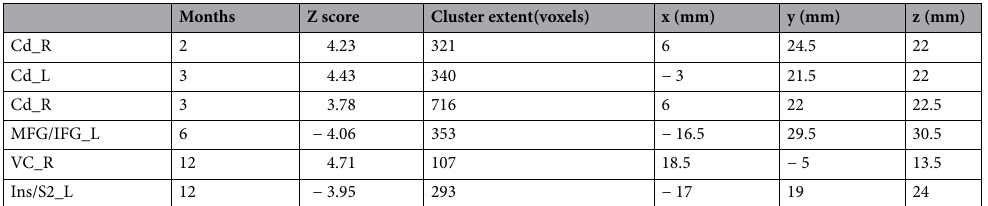
Table 1. GMV differences between the LC and NT3 animals. L left, R right, Cd caudate nucleus, MFG middle frontal gyrus, IFG inferior frontal gyrus, VC visual cortex, Ins insula, S2 secondary somatosensory cortex.